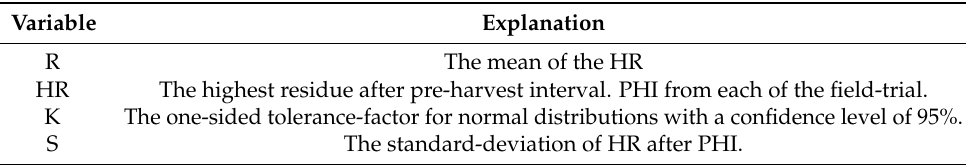
Table 1. Variable’s explanation of the equation of the MRL estimation. Variable Explanation R The mean of the HR HR The highest residue after pre-harvest interval. PHI from each of the field-trial. K The one-sided tolerance-factor for normal distributions with a confidence level of 95%. S The standard-deviation of HR after